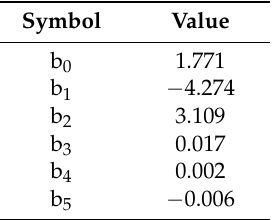
Table 10. Estimated coefficients for estimating load factor from Finnmarken